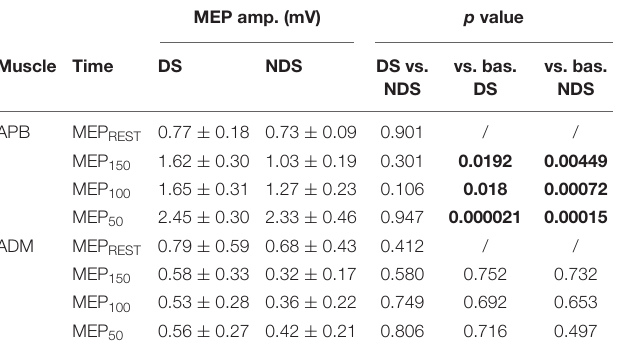
TABLE 2 | Motor evoked potential amplitude at rest and after TMS.